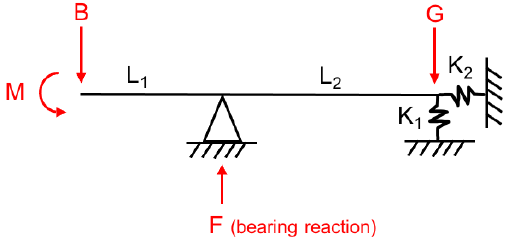
Table 1. Parameters for all